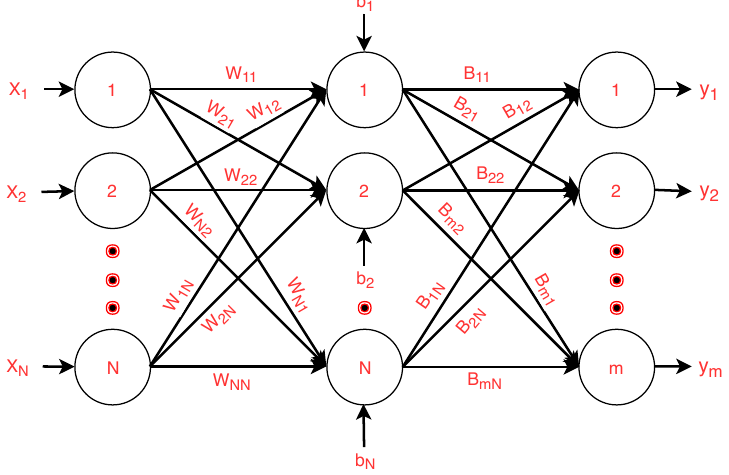
Figure 3. C-ELM with N input nodes, N hidden nodes and m output